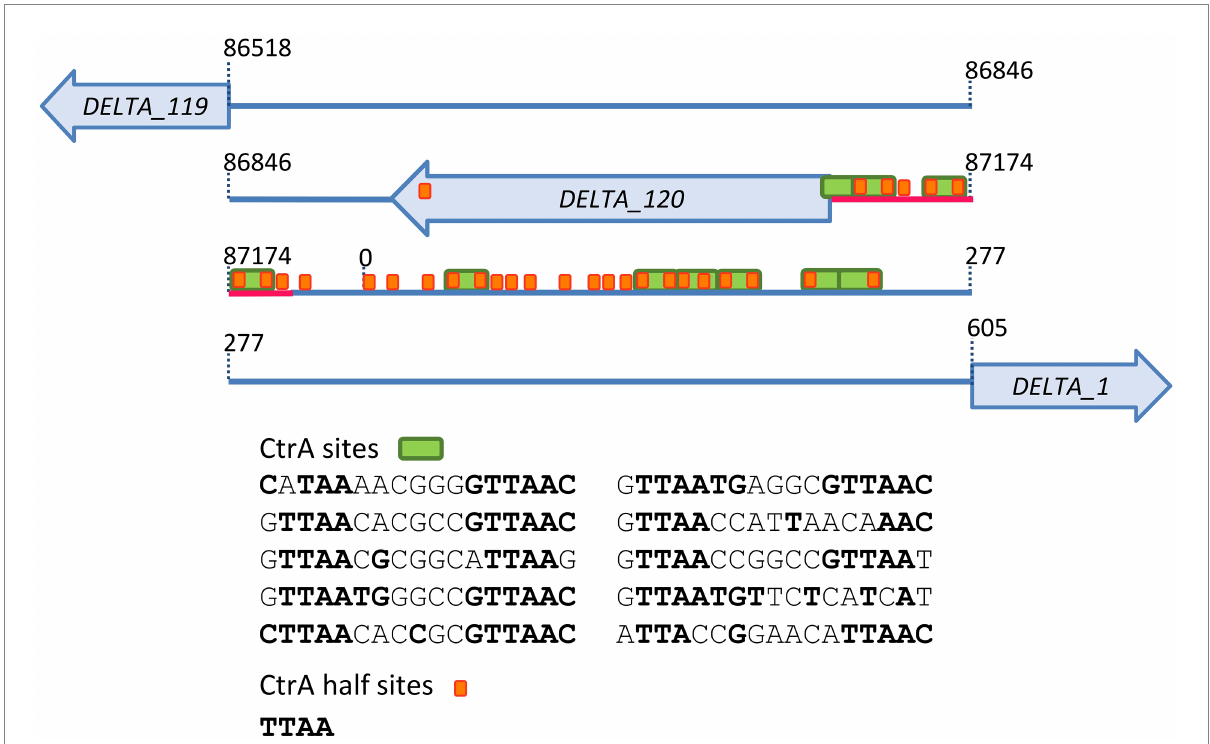
FIGURE 5 Brevundimonas phage vB_BsubS-Delta gap region diagram. The positions of putative CtrA-binding sites and half-sites in Brevundimonas phage vB_BsubS-Delta gap region are displayed as green and orange boxes, respectively. Their sequences are reported, with consensus-matching bases in bold. The location of protein coding genes, including the predicted DELTA_120 open reading frame, is also shown. The 81 bp probe upstream of DELTA_120 used in electromobility shift assays is underlined in